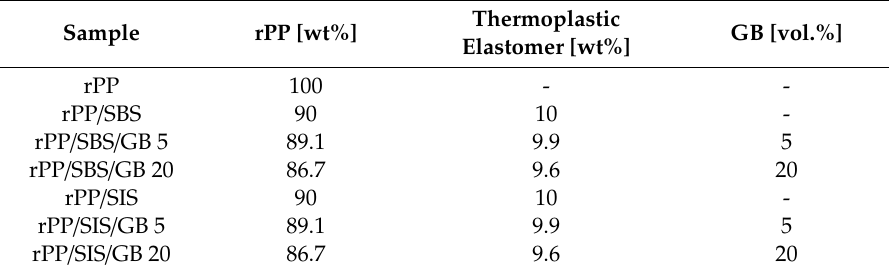
Table 1. Compositions for post-consumer recycled polypropylene (rPP) compounds.